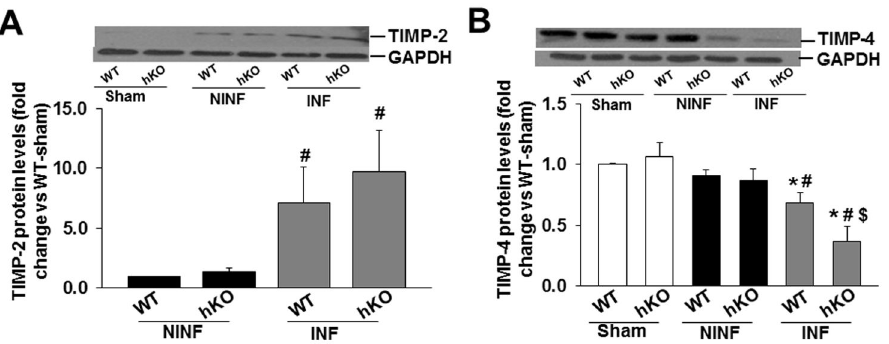
Figure 7. Expression of TIMPs. Total LV lysates (50 µg), prepared from sham and non-infarct (NINF) and infarct (INF) LV regions, were analyzed by western blot using anti-TIMP-2 (A) and anti-TIMP-4 (B) antibodies. The upper panels show autoradiograms indicating immunostaining for TIMP-2, TIMP-4, and GAPDH. The lower panels exhibit quantitative analyses of TIMP-2, TIMP-4 normalized to GAPDH. *p<0.05 vs sham; # p<0.05 vs NINF; $ p<0.05 vs WT-INF; n=7.